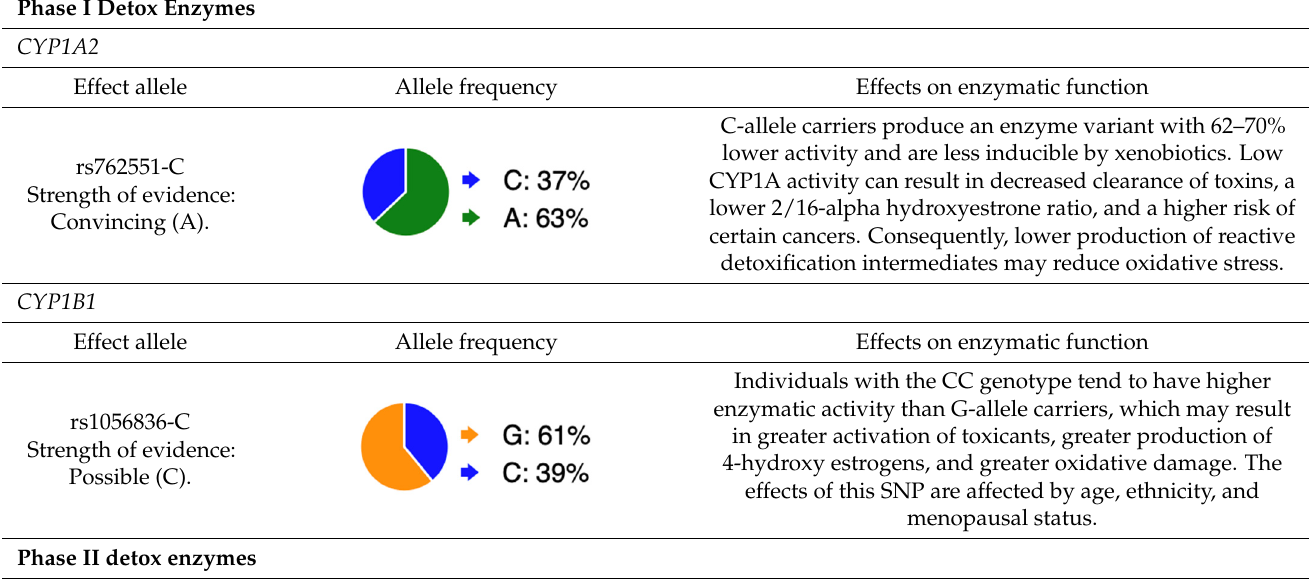
Table 1. Common genetic variants within genes involved in Phase I/Phase II detox reactions associated with variability of response to foods or nutrients that modulate detox metabolism.